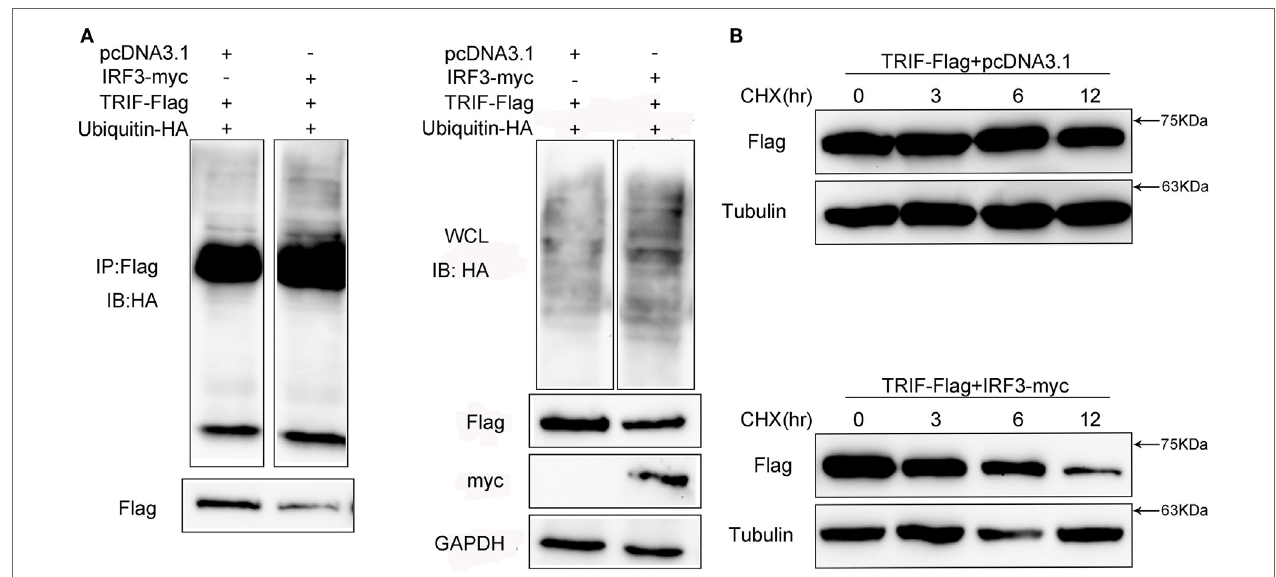
FigUre 9 | IRF3 leads to TRIF degradation by the ubiquitin–proteasomal pathway. (a) HEK293 cells were co-transfected with TRIF, IRF3, and ubiquitin-HA plasmids, after 48 h post-transfection, the cells were lysed and immunoprecipitation analysed with Flag antibody and then WB with antibody against HA. Samples of whole-cell lysate were included as controls. The relative levels of ubiquitinated TRIF are shown below the images after normalization with TRIF level. (B) HEK293 cells were transiently co-transfected with TRIF and IRF3 plasmids, after 36 h, the cells were treated with cycloheximide (100 µg/ml) and harvested at different times, followed by immunoblot assays with antibodies against Flag and tubulin. The relative levels of TRIF are shown below the images after normalization with